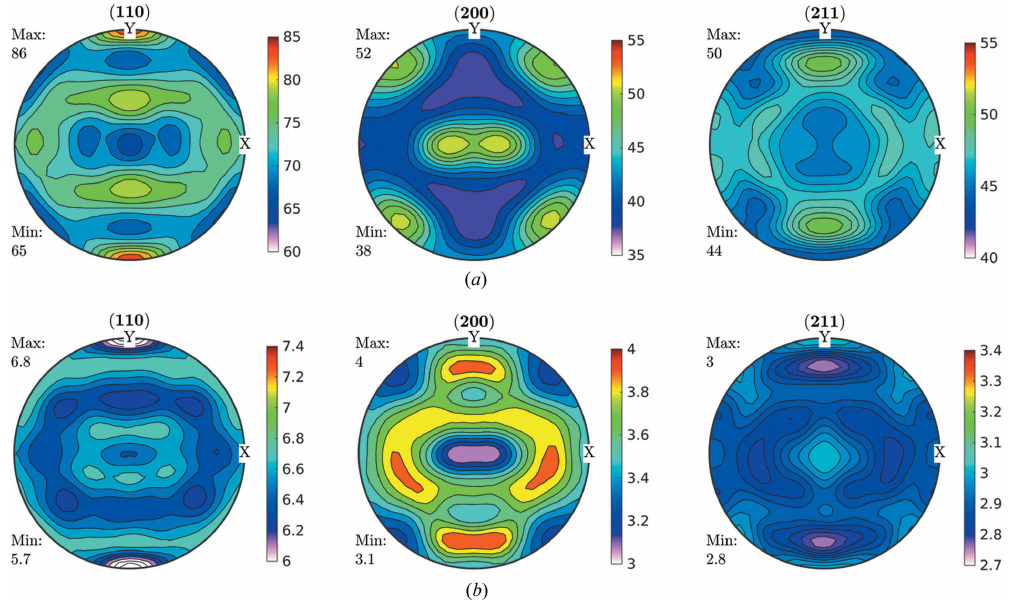
Figure 8 Recalculated GPFs for ( a ) domain size (nm) and ( b ) dislocation density ( (cid:4) 10 14 m (cid:3) 2 ), as separated by following the Langford model from FWHM GPFs for the IF cold-rolled sample. As well as for FWHM GPFs, we can see great consistency between recalculated and measured